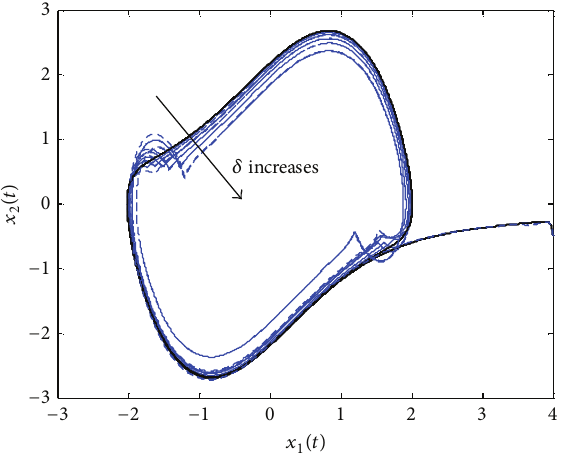
Figure 8: Phase portrait of the actual and approximate systems. the approximate truncated model is given with ℓ = 1 < 2 = 𝑛